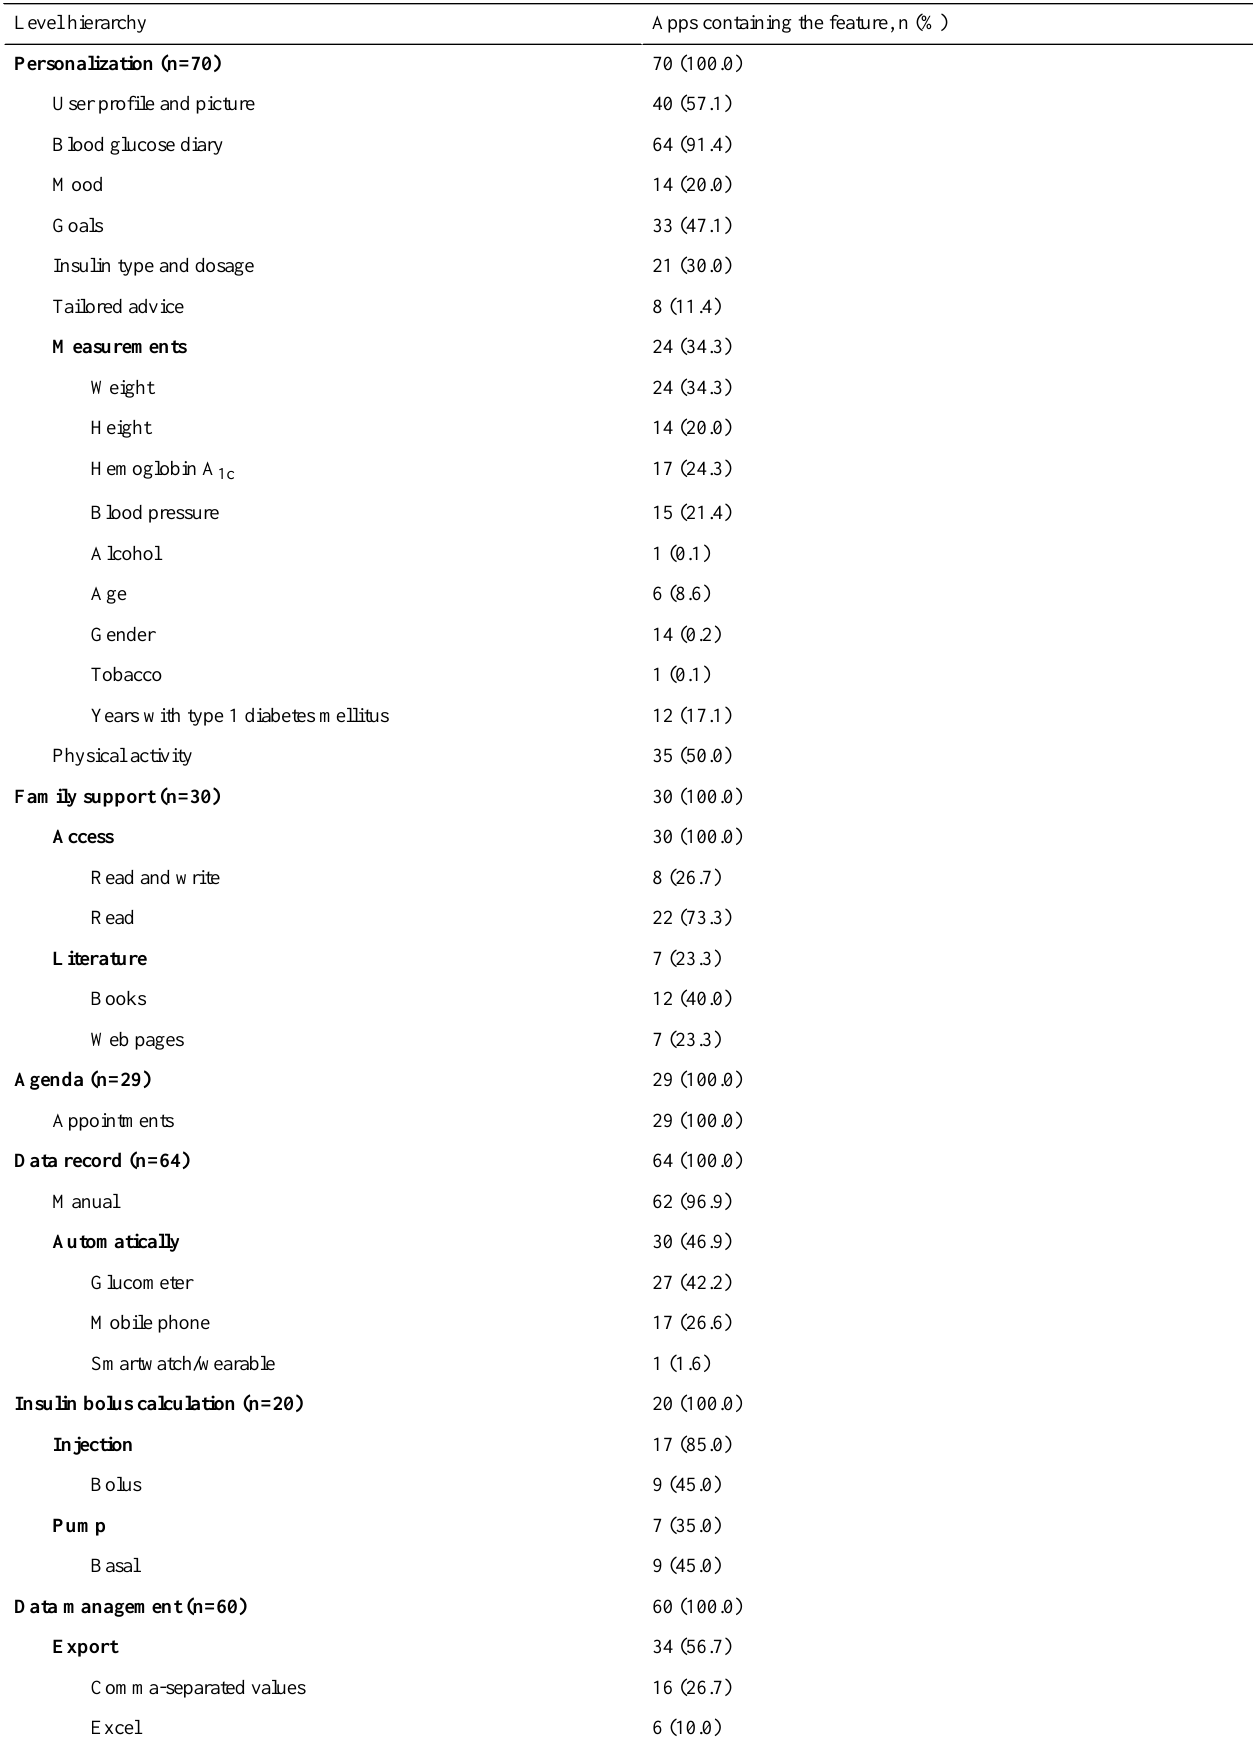
Table 3. Feature frequency in the reviewed diabetes management apps for the 3 hierarchy